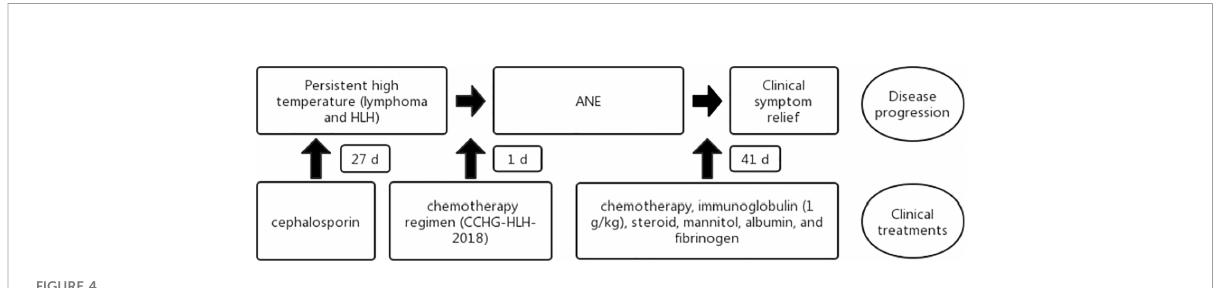
FIGURE 4 Flowchart of the patient disease progression and clinical treatments. HLH, hemophagocytic lymphohistiocytosis; ANE, acute necrotizing